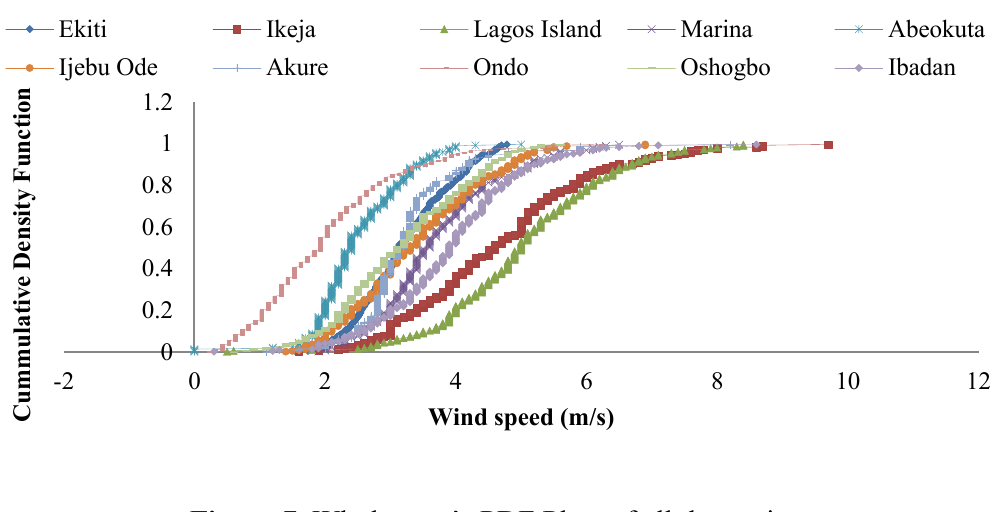
Figure 6. Whole year’s CDF Plots of all the stations.